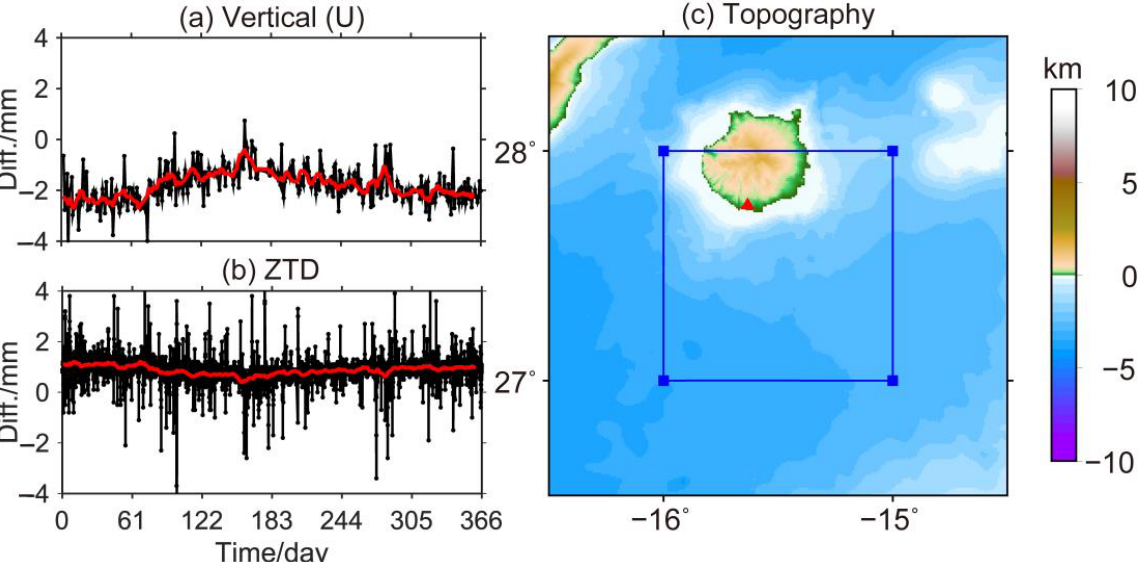
a site-wise empirical model and is interpolation free with no accuracy loss in its usage.